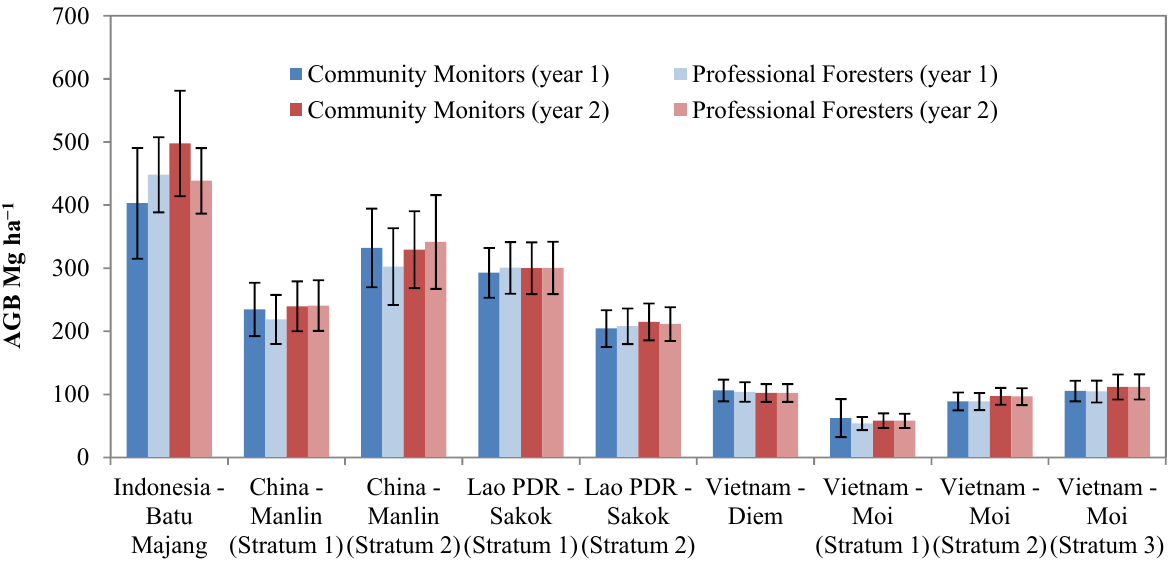
Figure 1. The identified above-ground woody biomass as measured by community monitors (blue) and professional foresters (red) in the two separate monitoring rounds done from September 2011 to May 2012 (Dark) and again from January 2013 to July 2013 (Light); error bars represent 95% confidence